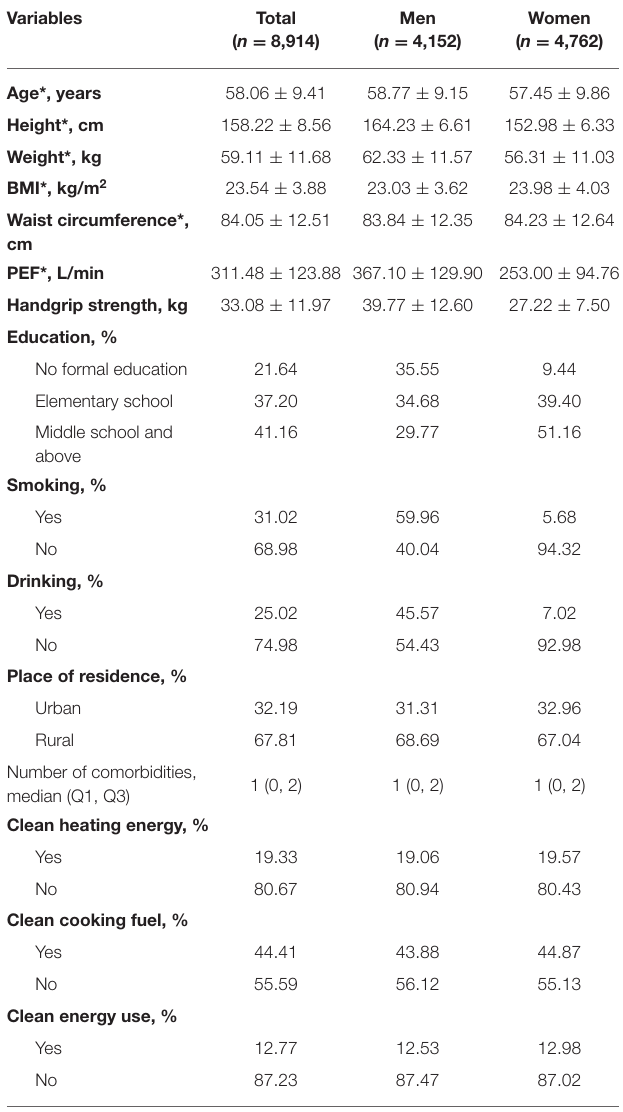
TABLE 1 | Demographic characteristics of the